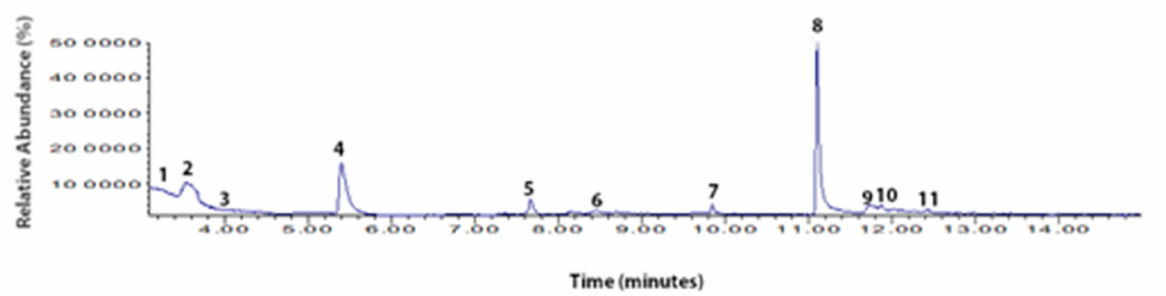
Figure 9. Total ion chromatogram of the VOCs and chemical composition in F-MC made with milk from Jersey cows. Chemical composition of SMF by HS-SPME/GC-MS with retention time(rt): 1 . Cyclotrisiloxane, hexamethyl-; 2 . Cyclotetrasiloxane, octamethyl-; 3 . 2-Methyl-7-phenylindole; 4 . Cyclopentasiloxane, decamethyl-; 5 . Cyclohexasiloxane, dodecamethyl-; 6 . 2-Hexen-4-ol, 5-methyl-; 7 . Cycloheptasiloxane, tetradecamethyl-; 8 . Propanoic acid, 2-methyl-, 3-hydroxy-2,4,4-trimethylpentyl ester; 9 . Nonahexacontanoic acid; 10 . 1,4-Dioxaspiro[4,5]decane-7-butanoic acid, 6-methyl-, 2- (methylsulfonyloxy)ethyl ester; 11 . 1-Monolinoleoylglycerol trimethylsilyl